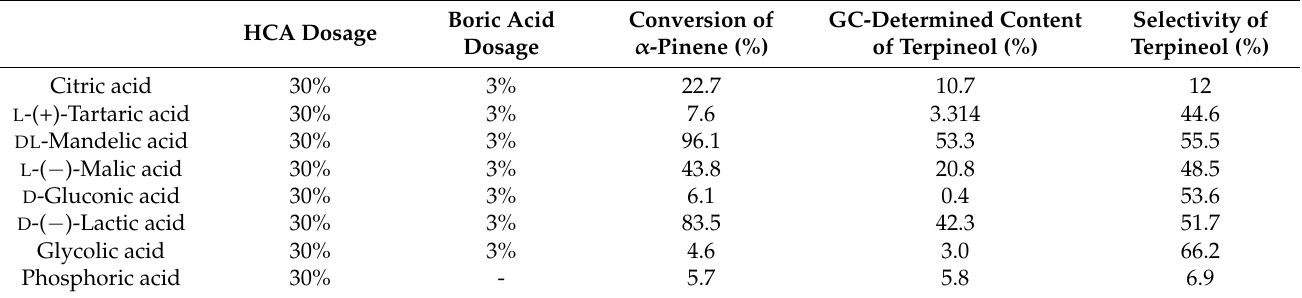
Table 2. Results of α -pinene hydration catalyzed by HCA–boric acid without a